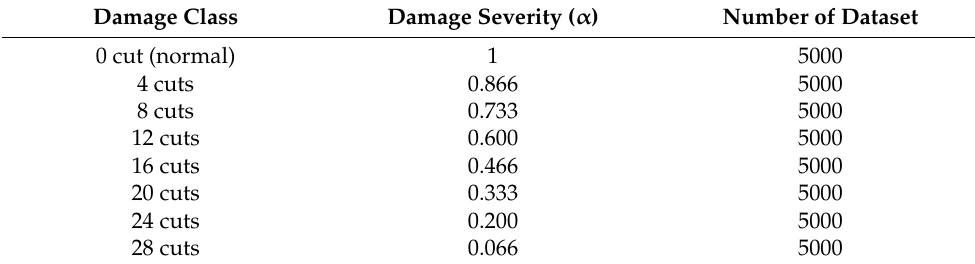
Table 3. Total dataset for each damage severity.